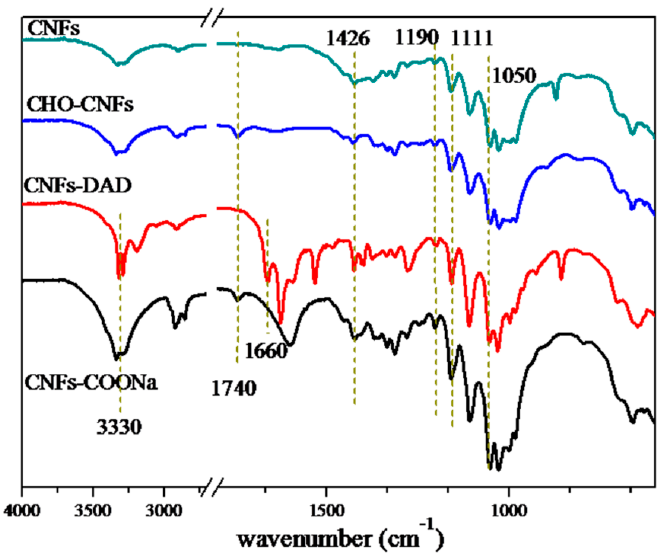
Figure 1. FTIR spectra of CNFs, CNFs-CHO, CNFs-DAD, and CNFs-COONa.